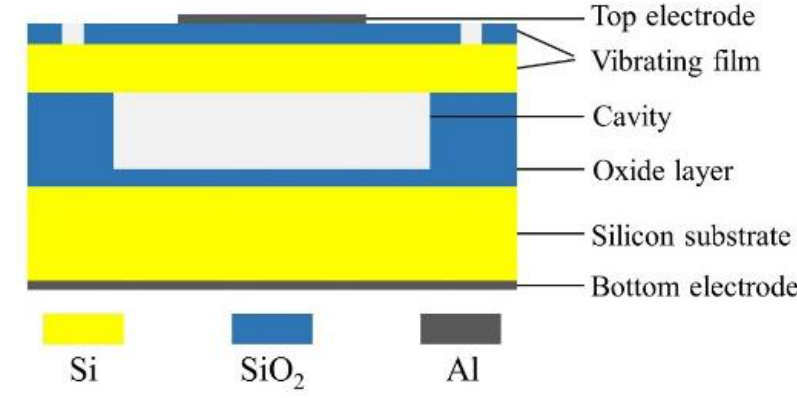
Figure 2. Structure of the CMUT cell.